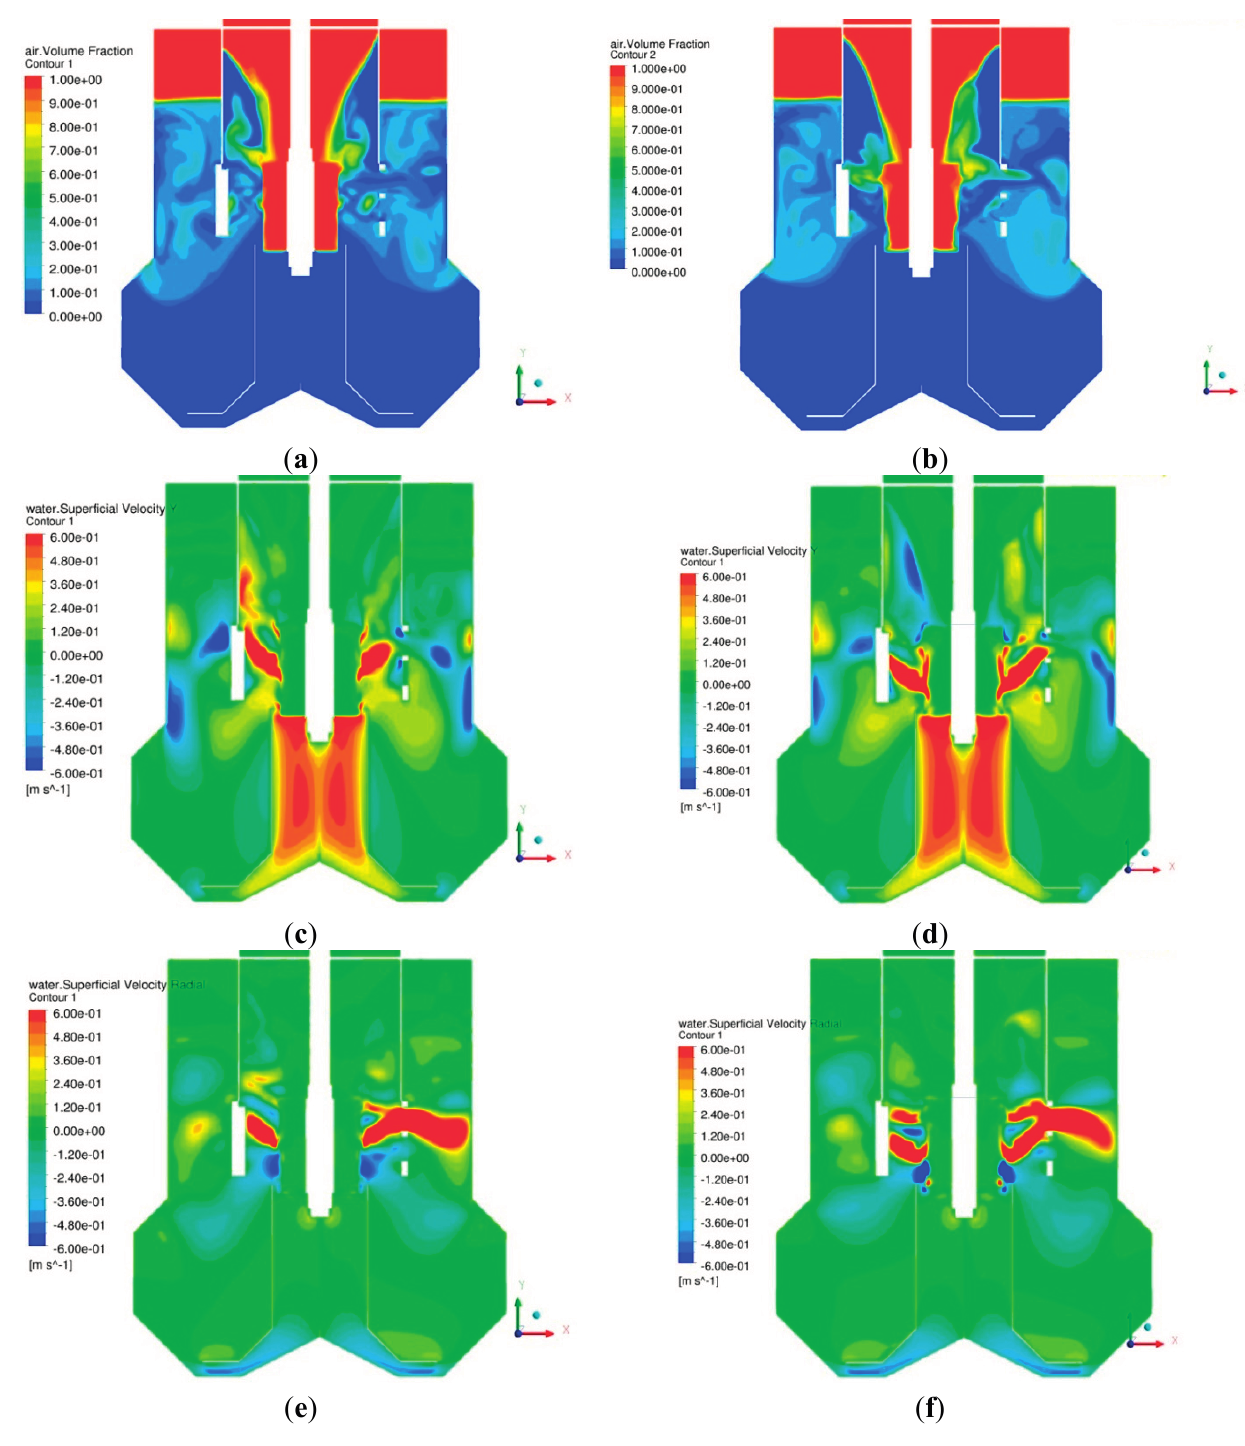
Figure 8. Air volume fraction and velocity contours for, d b = 0.7 mm ( a ) air volume fraction, t = 14.35 s; ( b ) air volume fraction, t = 15.4 s; ( c ) water superficial vertical velocity, t = 14.35 s; ( d ) water superficial vertical velocity, t = 15.4 s; ( e ) water superficial radial velocity, t = 14.35 s; ( f ) water superficial radial velocity, t = 15.4